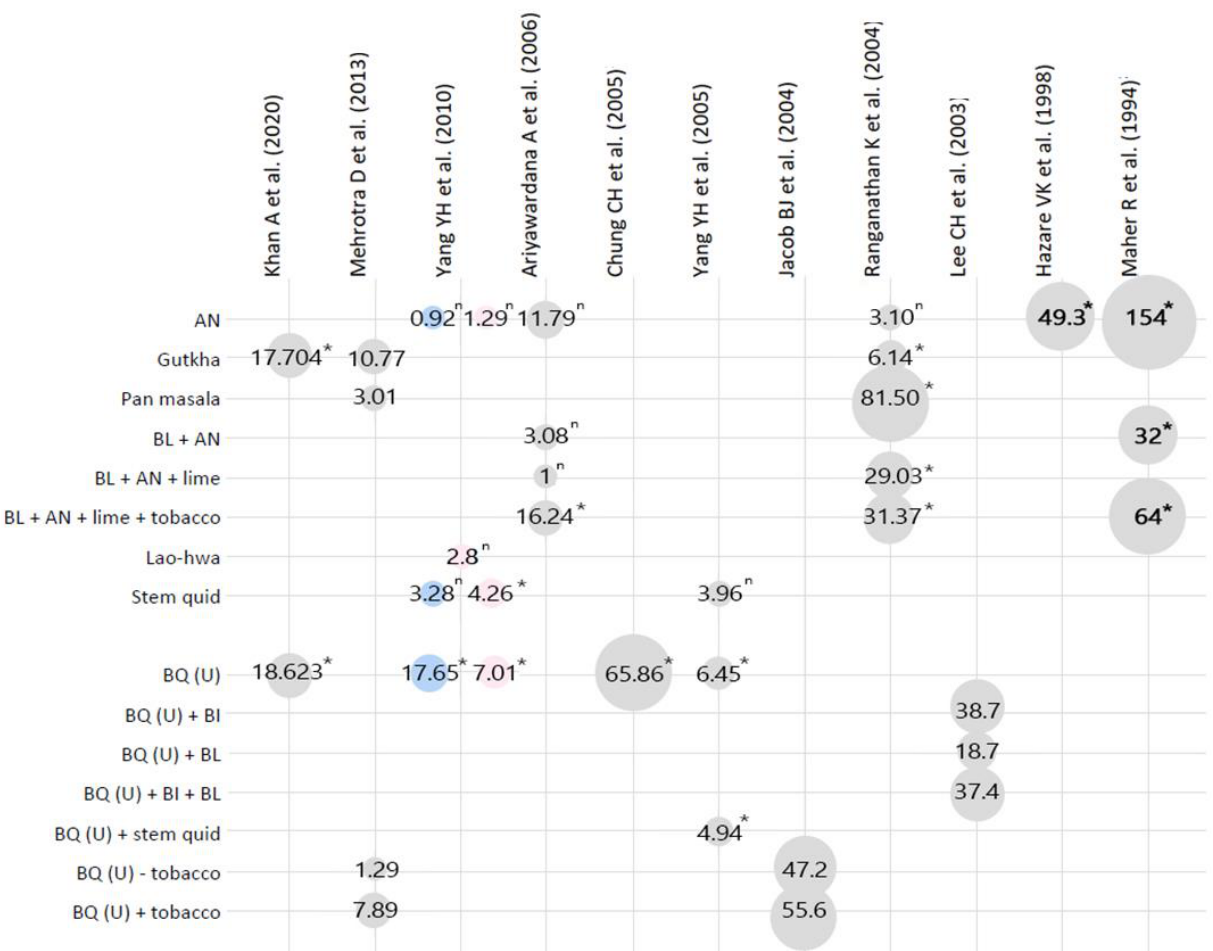
Figure 2. Overview of betel quid mixtures and their associated OR or RR values for OSF. n , not significant to the 0.05 power. *, p -value < 0.05. Pink, females; Blue, males; grey, both genders. AN = areca nut; BL = betel leaf; BQ (U) = betel quid unspecified mixture; BI = betel